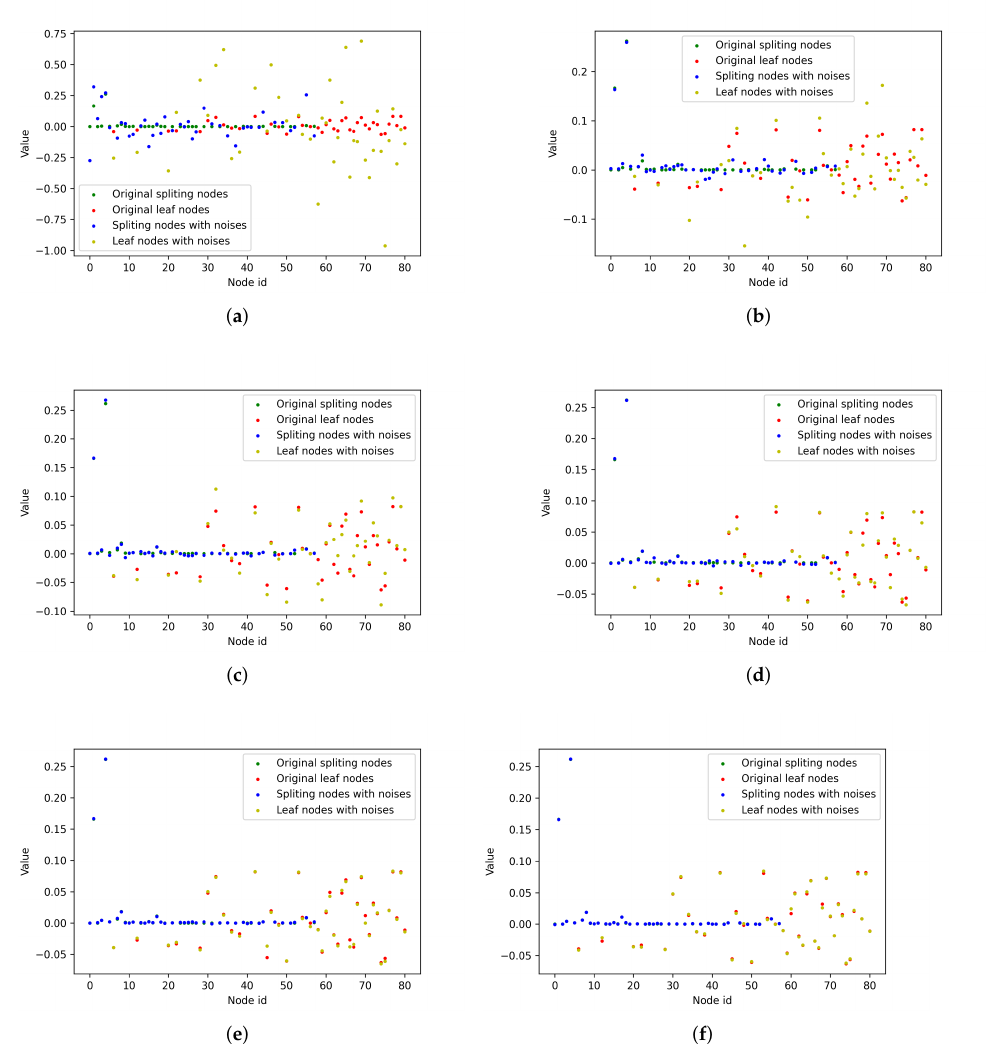
Figure 8. The noises added to the leaf nodes for different (cid:101) ( h = 10). ( a ) (cid:101) = 0.5. ( b ) (cid:101) = 5. ( c ) (cid:101) = 10.